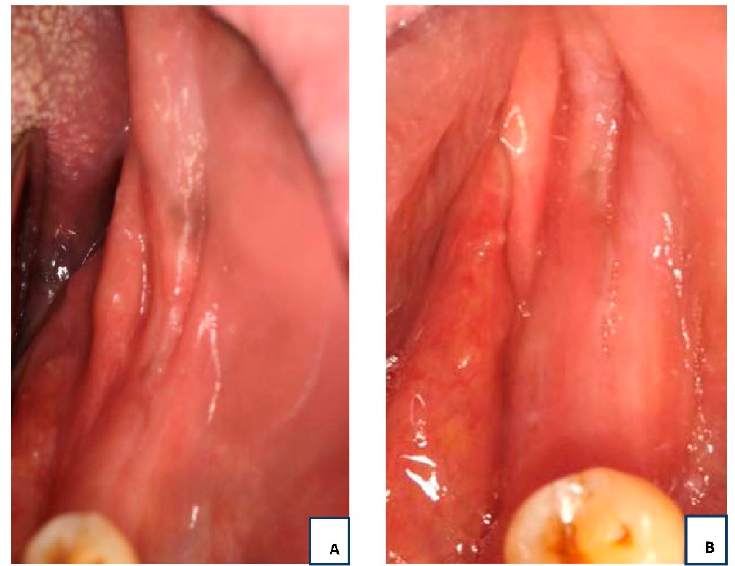
Figure 5. Clinical photos showing complete healing with no evidence of necrotic bone on the left posterior alveolar ridge of the mandible. ( A ) Follow up after management and before dentures fabrication. ( B ) 3 months post dentures insertion.